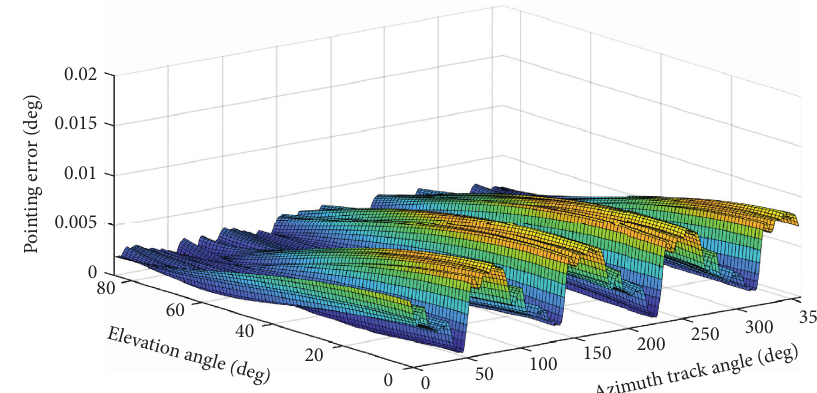
Figure 10: Telescope pointing error for a four-support-point case.